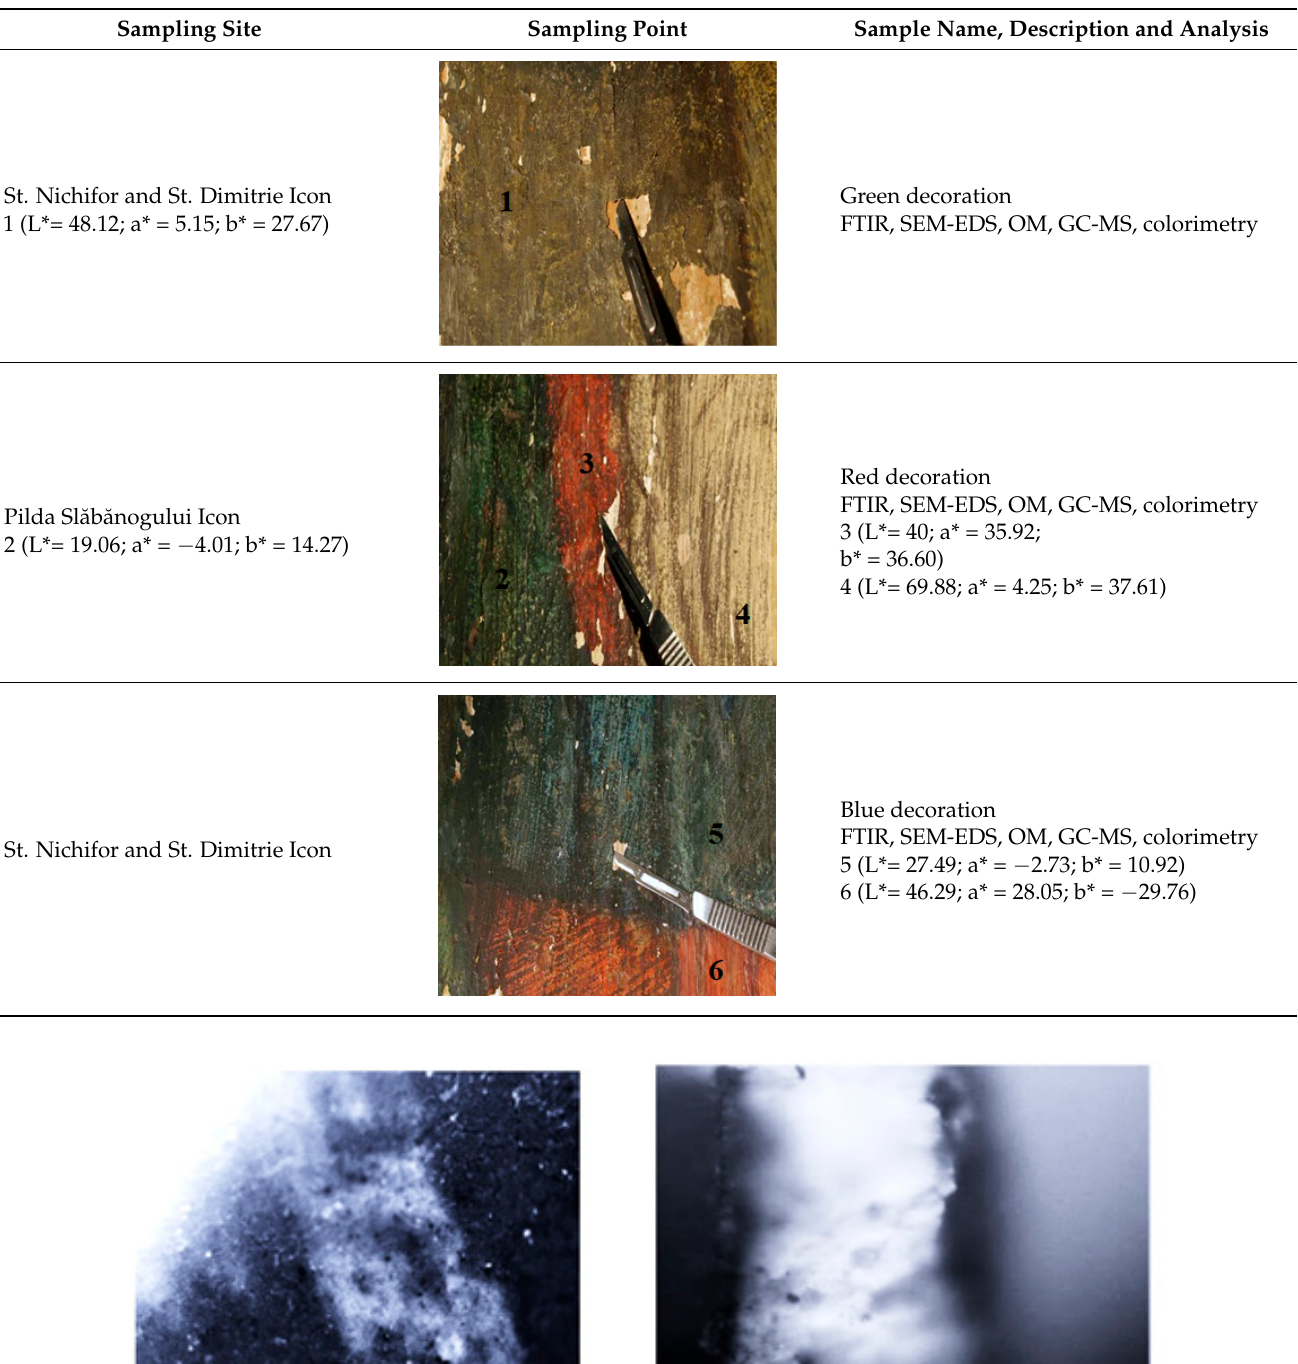
Table 1. The description of the samples collected from Techirghiol church (Church Naos – eastern part). Sampling site